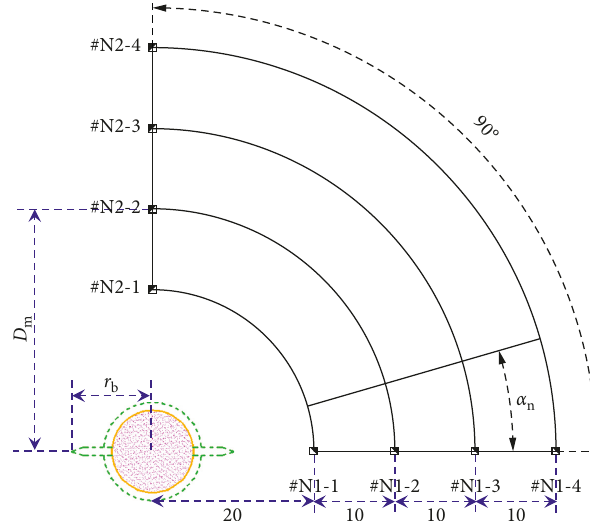
Figure 12: Schematic diagram of monitoring point layout.